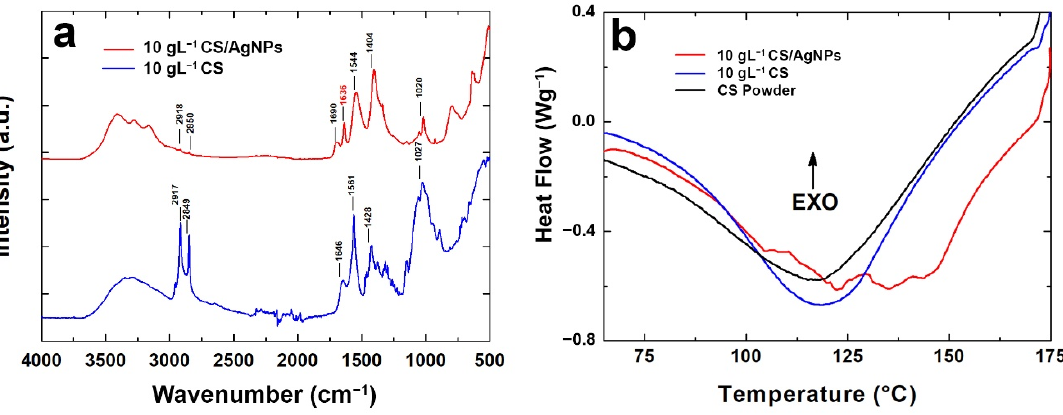
Figure 5. ( a ) FT-IR spectra and ( b ) DSC analysis of the coating with and without Ag nanoparticles. The broad peak of CS at 3330 cm − 1 represents an overlap between O–H and N–H stretching vibrations the polysaccharide moieties [105]. For the CS/AgNPs sample, CS band relative to the hydroxyl groups shifted to a lower wavenumber and they are divided into three smaller bands likely due to the interaction of amide and amine groups with AgNPs [105]. In addition, the amide B bands in the CS/AgNPs spectrum, at 2850 cm − 1 , are smaller than pure CS, indicating the reduction in the hydrogen bond due to an interaction with AgNPs [106]. In addition, the characteristic shoulder peak of the amide-I (stretching), found at 1647 cm − 1 in CS, shifts to 1636 cm − 1 for CS/AgNPs films and it is reduced in